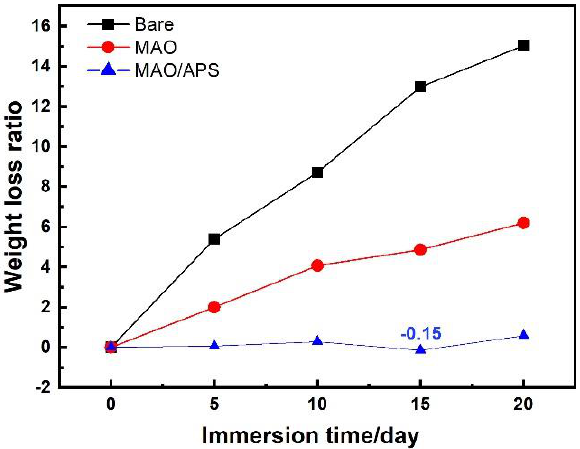
Figure 8. Weight loss rate of samples over time.